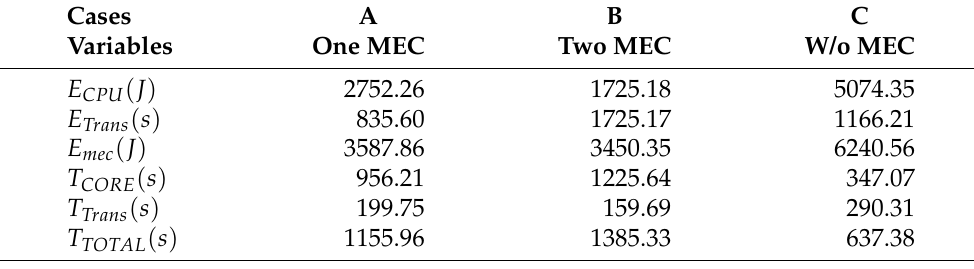
Figure 2. Task allocation for Application 1 and Application 2. Table 5. The MEC server benefit related to the energy